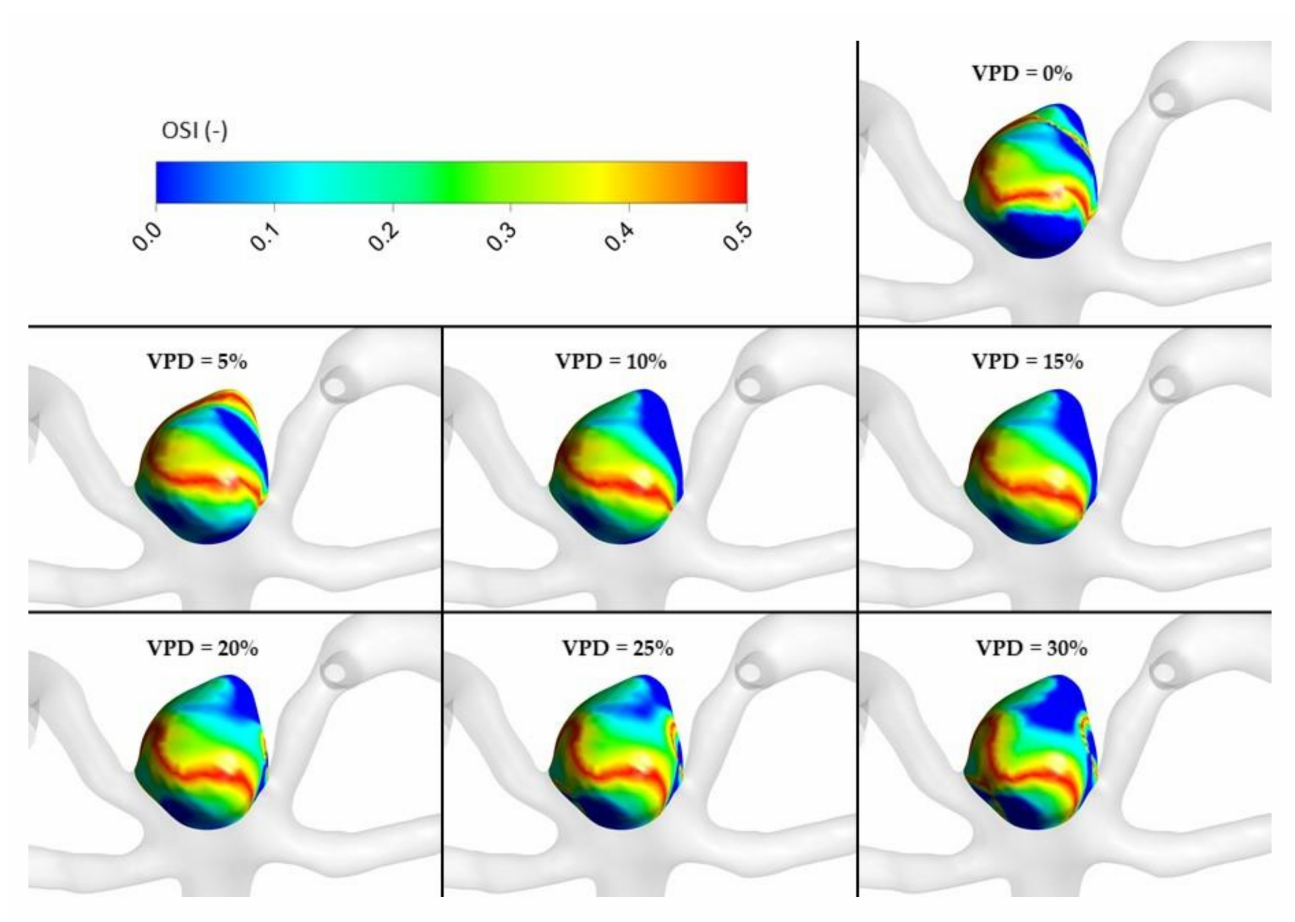
Figure 20. OSI distribution at aneurysm wall for selected VPD cases; transient simulations—cycle-averaged